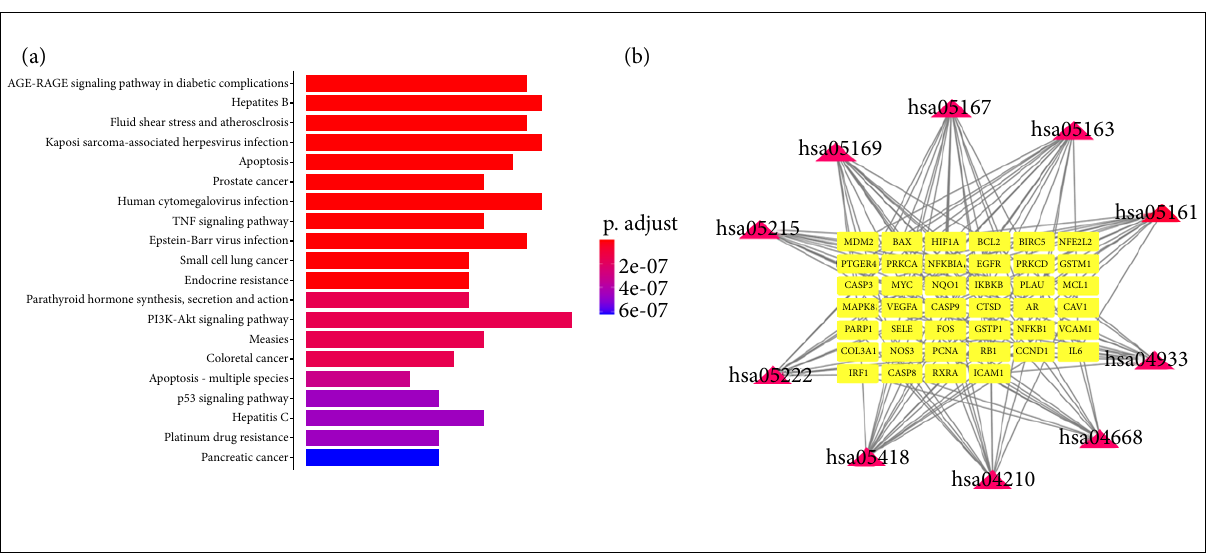
Figure 4 - Kyoto Encyclopedia of Genes and Genomes enrichment analysis of common target gene. (a) The top 20 signal pathway. (b) The top 10 target-pathway network for Lutongkeli. The red and yellow nodes represent the pathway and targets, respectively, and the edges represent the interactions among them.